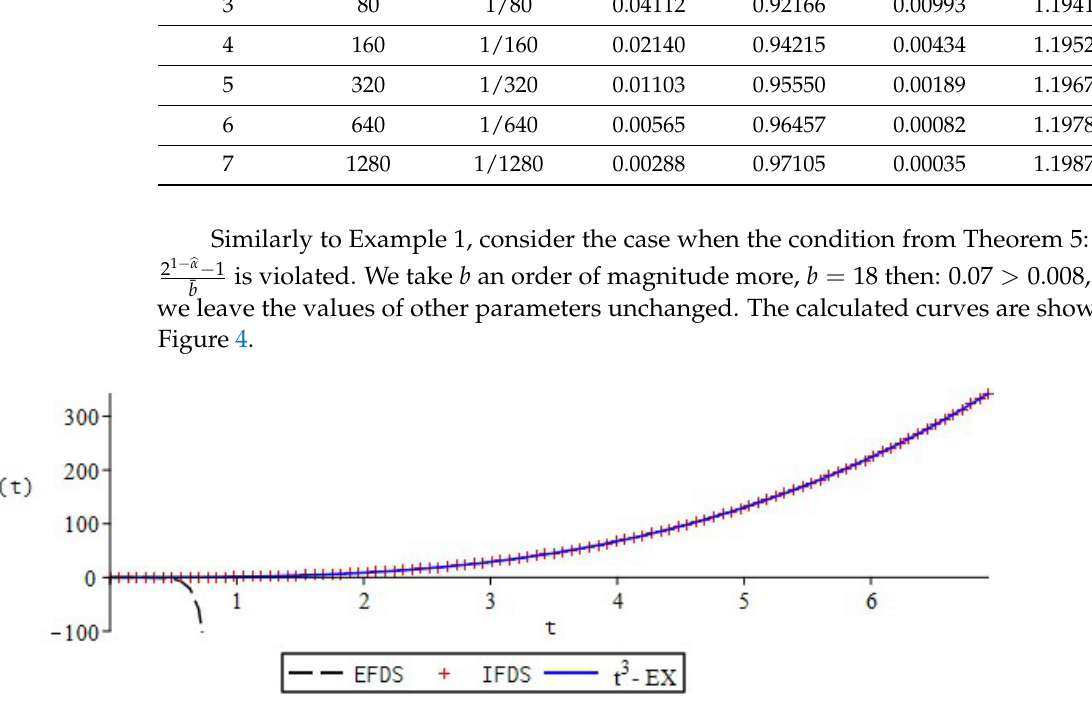
Figure 4. Exact solution EX and numerical solutions of the fractional Riccati equation with constant coefficients and α = 0.8 when the condition is